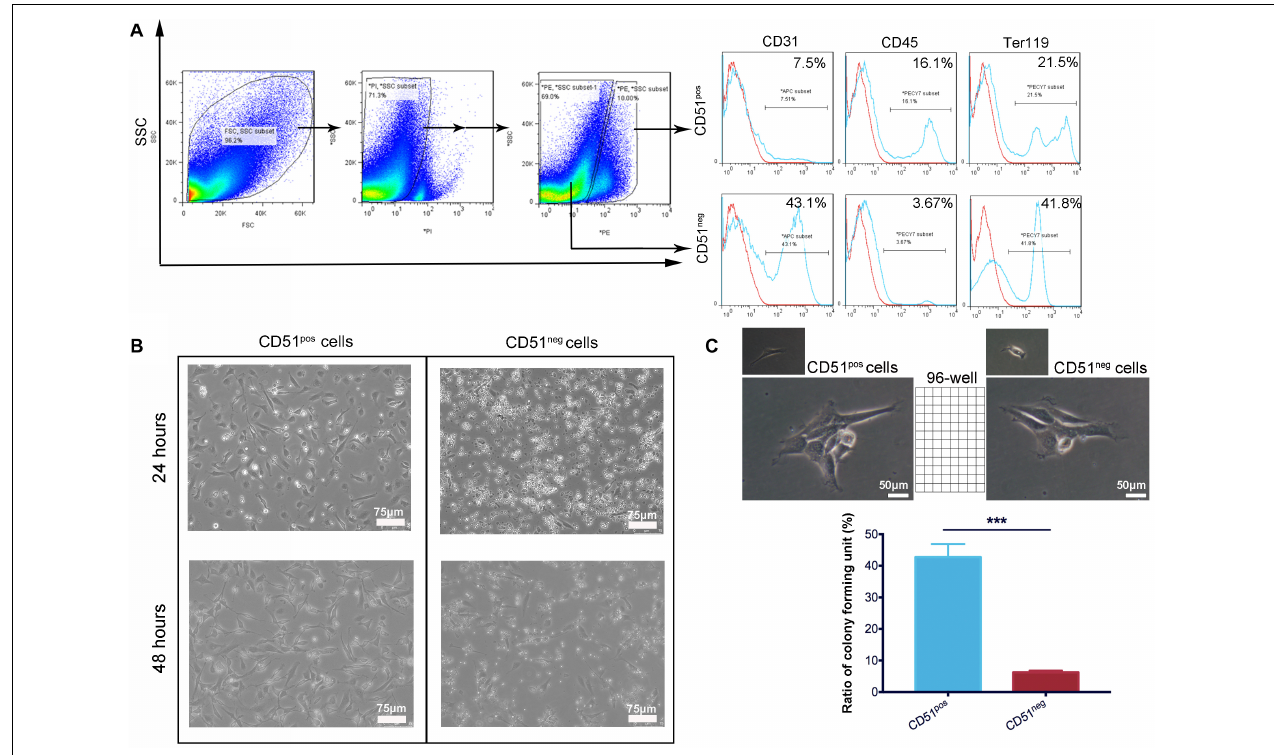
FIGURE 2 | Comparison of cardiac CD51 pos cells and CD51 neg cells from 7-day-old mice. (A) Cardiac CD51 pos cells and CD51 neg cells were isolated by flow cytometry, and expression of CD31, CD45, and Ter119 in the CD51 pos and CD51 neg subpopulations was also analyzed; propidium iodide (PI) staining was used to discriminate dead cells. (B) Images of the cultured CD51 pos cells and CD51 neg cells, freshly sorted cells were cultured for 24 or 48 h in the medium. (C) Clone formation experiment: freshly sorted single cells were seeded in untreated 96-well plates and cultured for 7 days (one cell per well); representative images of replicated CD51 pos cells and CD51 neg cells were exhibited; structures with three or more cells in each well were considered to have clone-formation potential, and the positive ratio was calculated as follows: (number of colony-like structures/96 inoculated) × 100%; values were presented as the mean ± SEM, n = 3, *** P < 0.001. Scale bars were marked in the